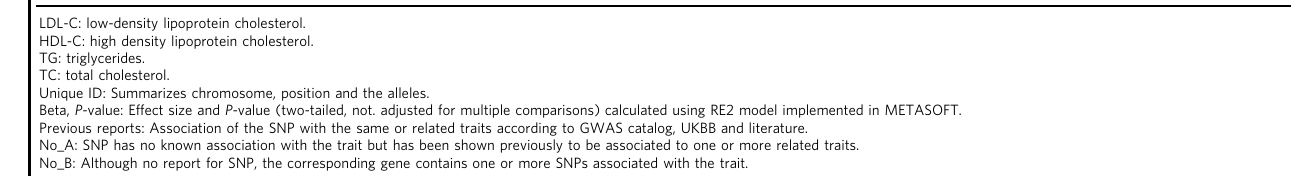
TG: triglycerides. TC: total cholesterol. Unique ID: Summarizes chromosome, position and the alleles. Beta, P -value: Effect size and P -value (two-tailed, not. adjusted for multiple comparisons) calculated using RE2 model implemented in METASOFT. Previous reports: Association of the SNP with the same or related traits according to GWAS catalog, UKBB and literature. No_A: SNP has no known association with the trait but has been shown previously to be associated to one or more related traits. No_B: Although no report for SNP, the corresponding gene contains one or more SNPs associated with the